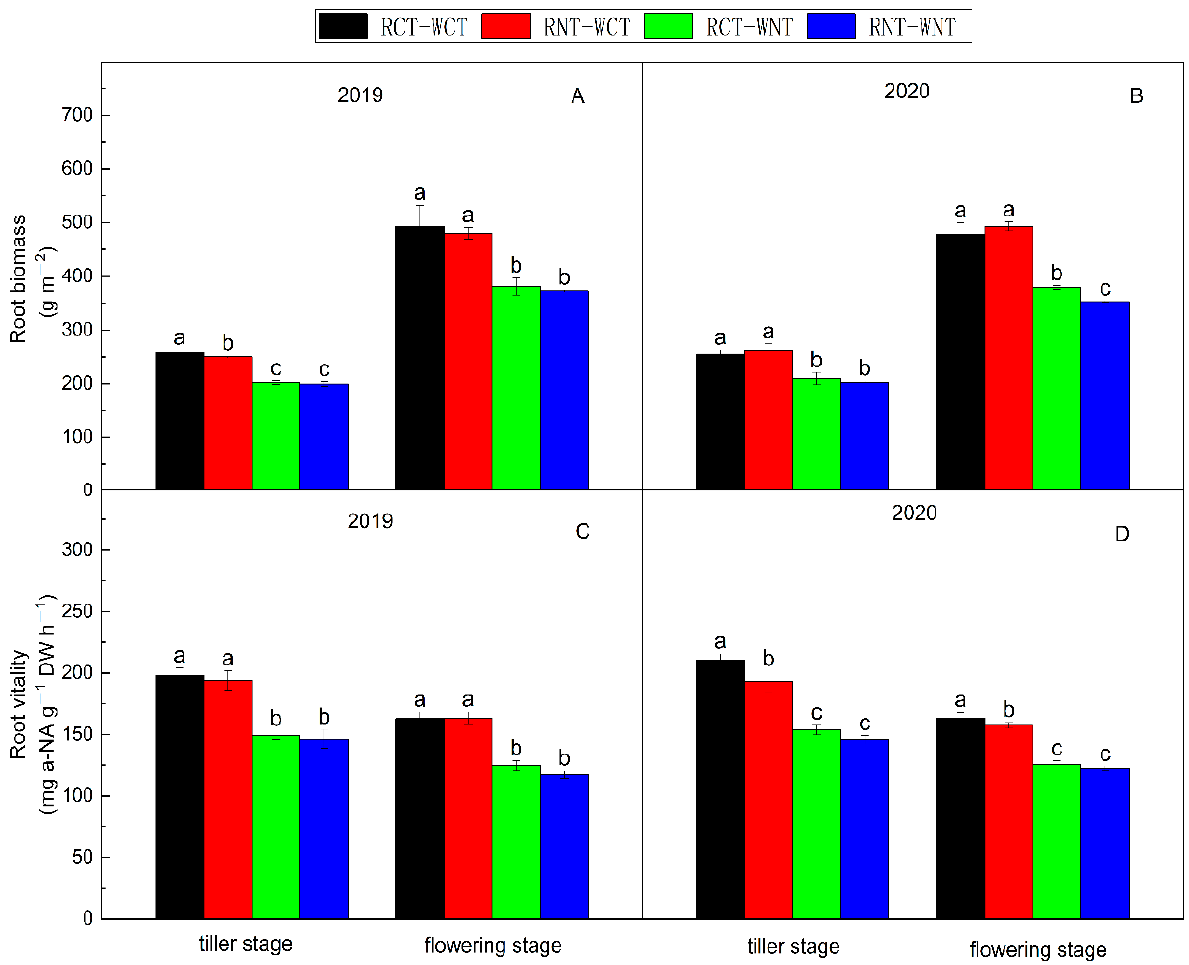
Figure 2. Root biomass in 2019 ( A ) and 2020 ( B ) and root vitality in 2019 ( C ) and 2020 ( D ) of rice under different tillage management methods. RCT–WCT, conventional tillage before transplanta- tion/sowing of each crop; RNT–WCT, no tillage before transplantation of rice and conventional till- age before sowing of wheat; RCT–WNT, conventional tillage before transplantation of rice and no tillage before sowing of wheat; RNT–WNT, no tillage before sowing of each crop. Different lower- case letters indicate statistical differences among treatments at p < 0.05.